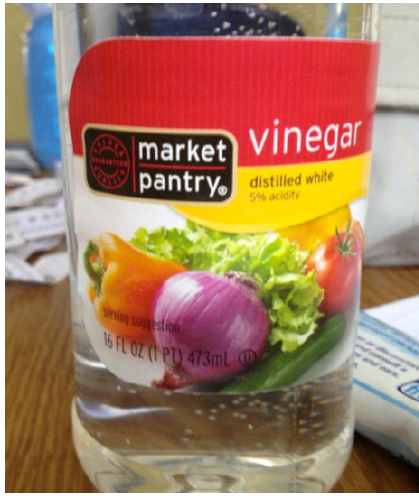
Acetic Acid (VIA)